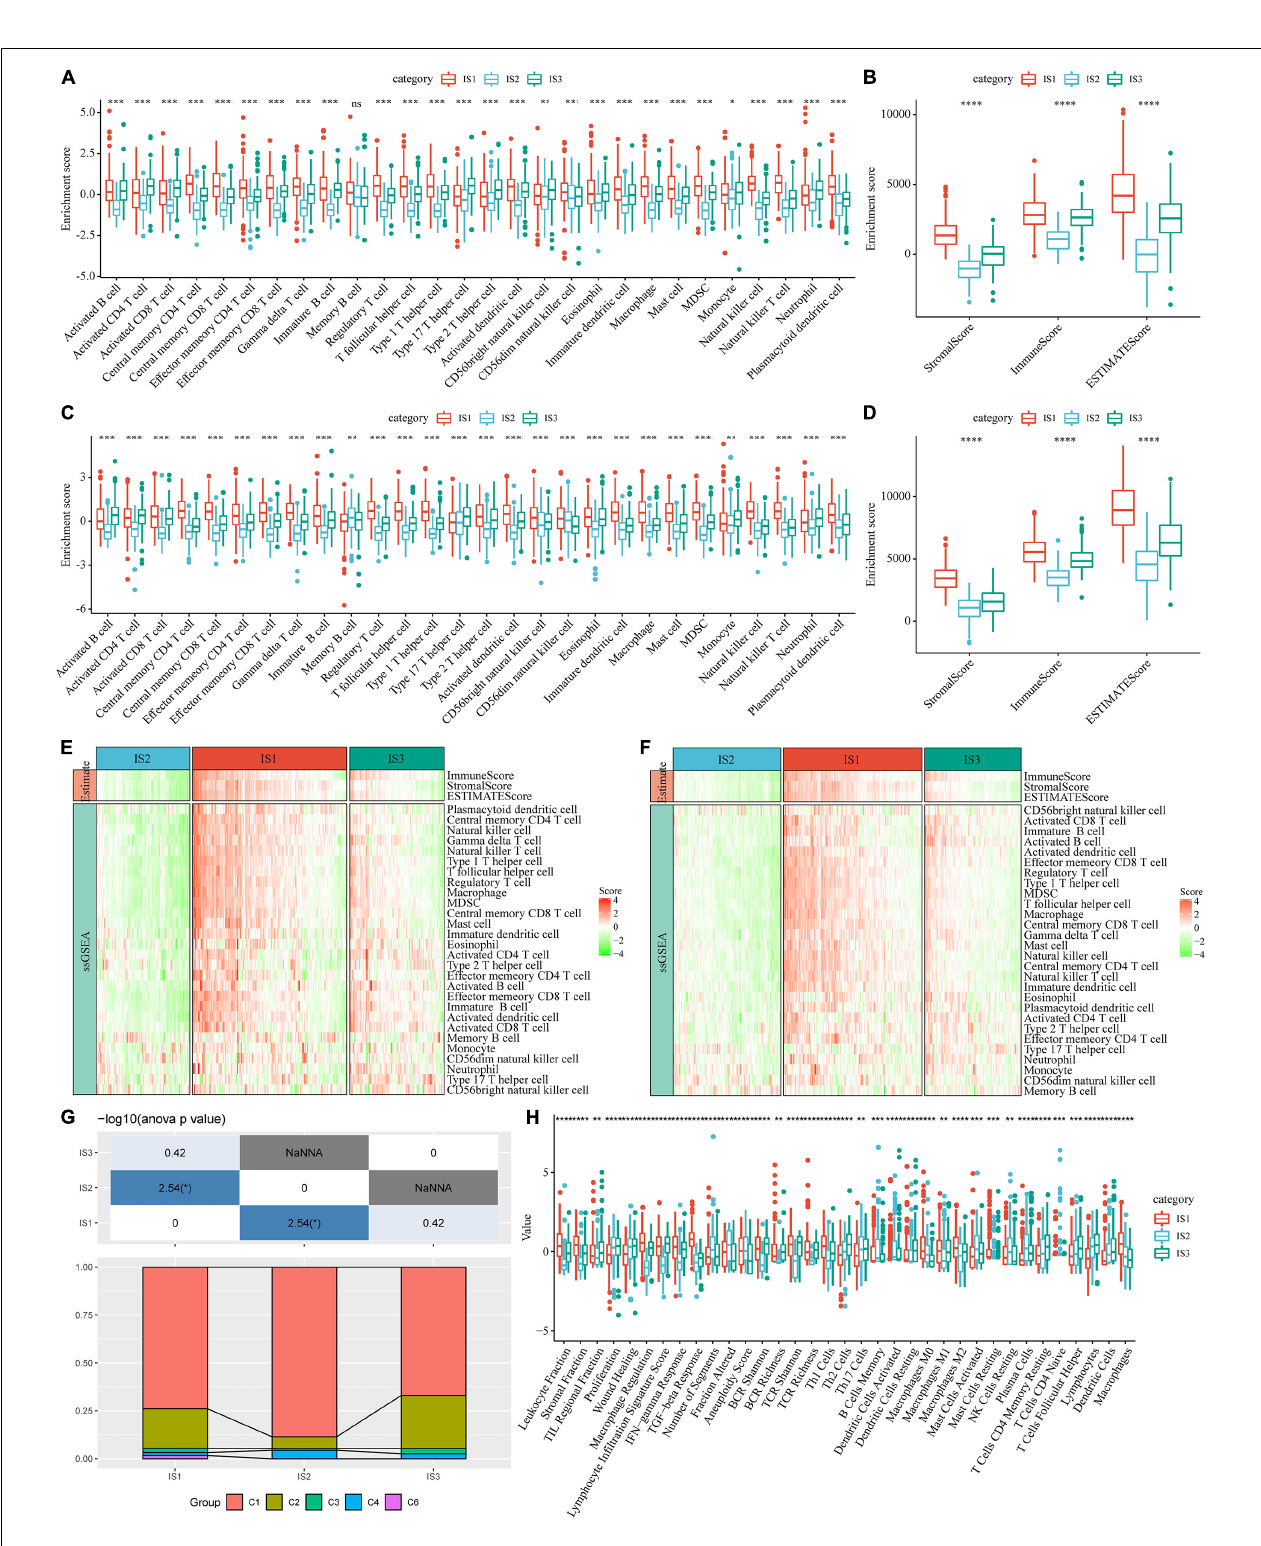
FIGURE 5 | Immune signatures in different immune subtypes. (A) Differences in the enrichment scores of 28 types of immune cells in each subtype of the TCGA-COAD cohort; (B) The immune score of each subtype in the TCGA-COAD cohort; (C) Differences in the enrichment scores of immune cells in the GSE39582 cohort; (D) Immune scores for each subtype in the GSE39582 cohort; (E) A heatmap depicting the immune score of patients in the TCGA-COAD cohort; (F) A heatmap depicting the immune score of patients in the GSE39582 cohort; (G) Intersection of three immune molecular subtypes with previous immune molecular subtypes; (H) The distribution of three immune subtypes in 56 immune-related features, out of which 35 immune features were significant (FDR < 0.01). * P < 0.05, ** P < 0.01, *** P < 0.001, and **** P < 0.0001.